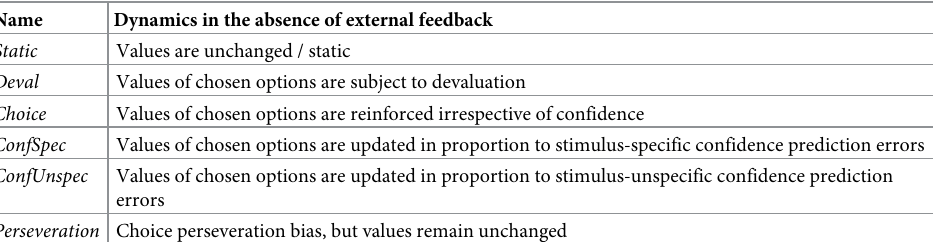
Table 1. Models. Name Dynamics in the absence of external feedback Static Values are unchanged / static Deval Values of chosen options are subject to devaluation Choice Values of chosen options are reinforced irrespective of confidence ConfSpec Values of chosen options are updated in proportion to stimulus-specific confidence prediction errors ConfUnspec Values of chosen options are updated in proportion to stimulus-unspecific confidence prediction errors Perseveration Choice perseveration bias, but values remain unchanged